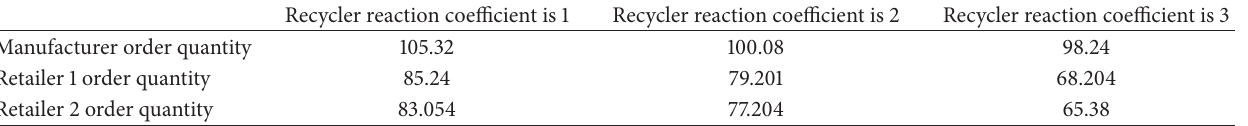
Table 2: Bullwhip effect of the order quantity of each member under different recycler’s coefficient.